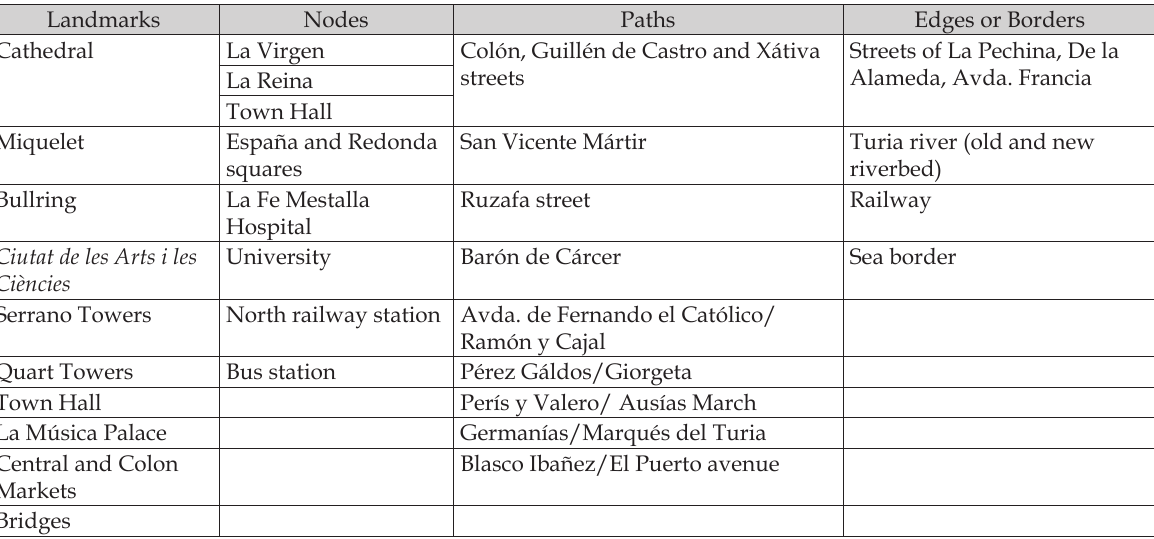
Table 3. Valencia’s elements highlighted by respondents in the categories established by Lynch (1960). Landmarks